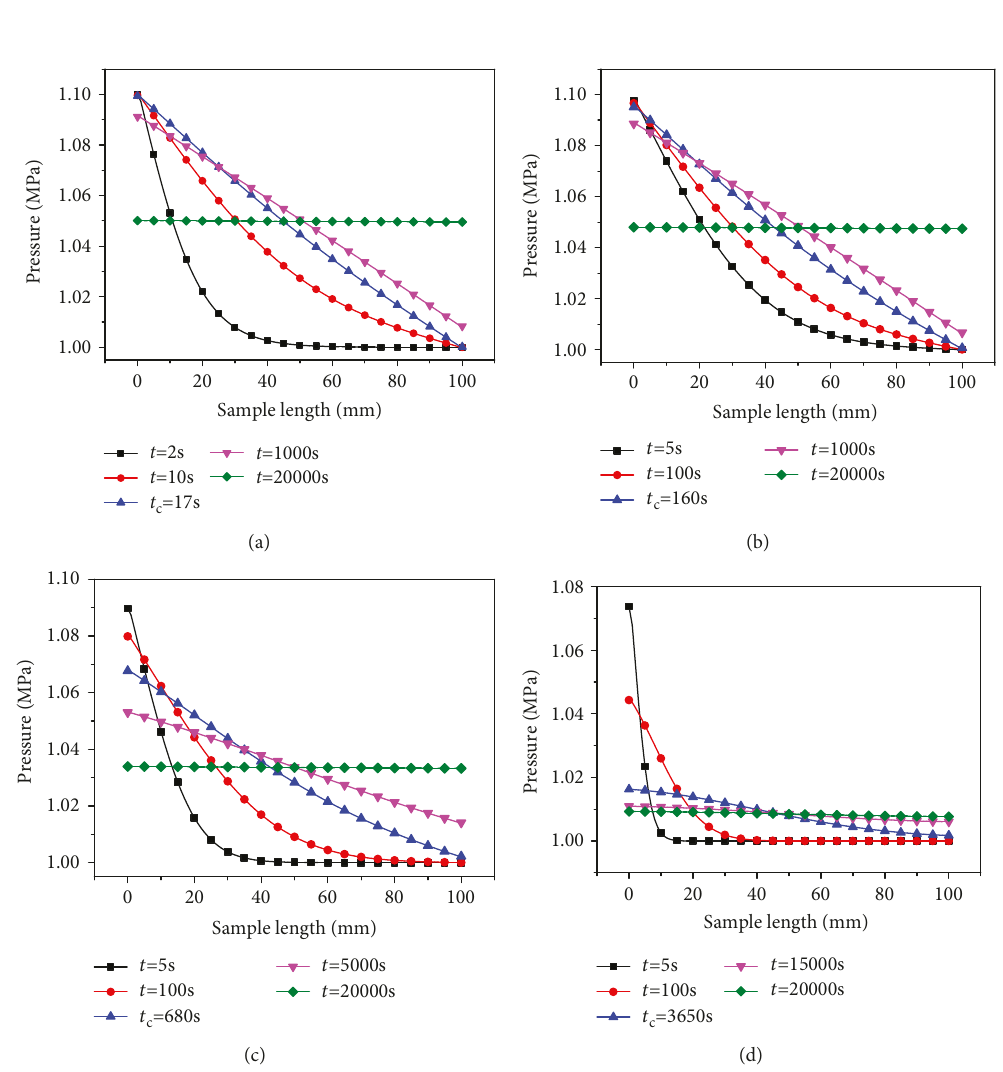
Figure 5: Pressure responses along the length of the sample at di ff erent real times: (a) case 1, (b) case 2, (c) case 3, and (d) case